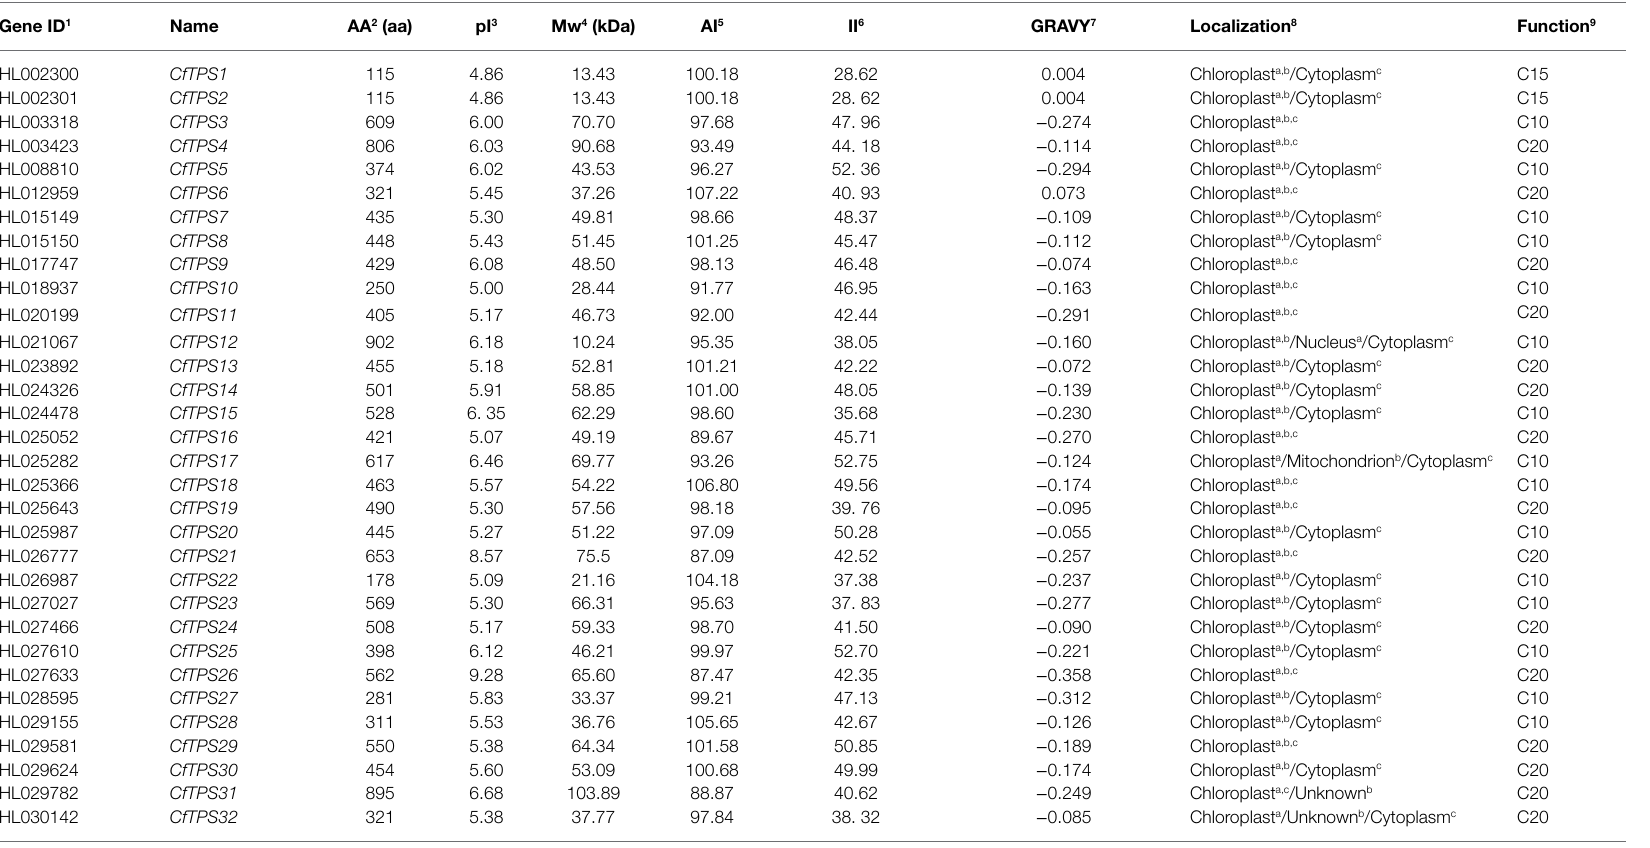
TABLE 1 | A list of TPS genes in C. faberi , their characteristics, and functional annotation. Gene ID